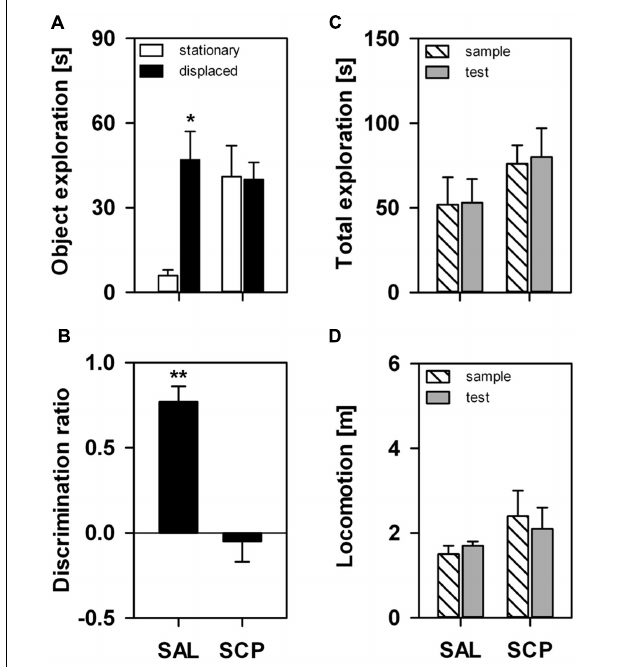
FIGURE 2 | Marmosets’ performance on the one-trial Spontaneous Object-Location (SOL) Recognition Task. An acute saline (SAL; n = 4) or scopolamine (SCP, 0.03 mg/kg SCP; n = 5) administration was given subcutaneously 20 min before the task. The sample and test trials lasted 10 min and were held at 10 min intervals. (A) Time spent in seconds exploring the stationary and displaced objects on the test trial; (B) Object discrimination ratio calculated for the test trial; (C) Time spent in seconds exploring both objects on the sample and test trials; and (D) Total distance traveled in meters during the sample and test trials. All data are represented as mean + SEM. ∗ p < 0.05 vs. the stationary object of the SAL group, ∗∗ p < 0.05 vs. zero-value chance level in the SAL